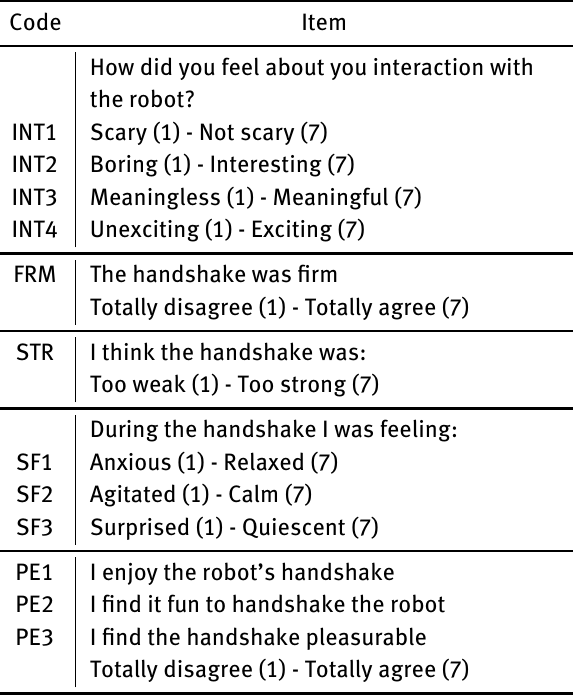
Table 7: Questionnaire used to evaluate and compare hand